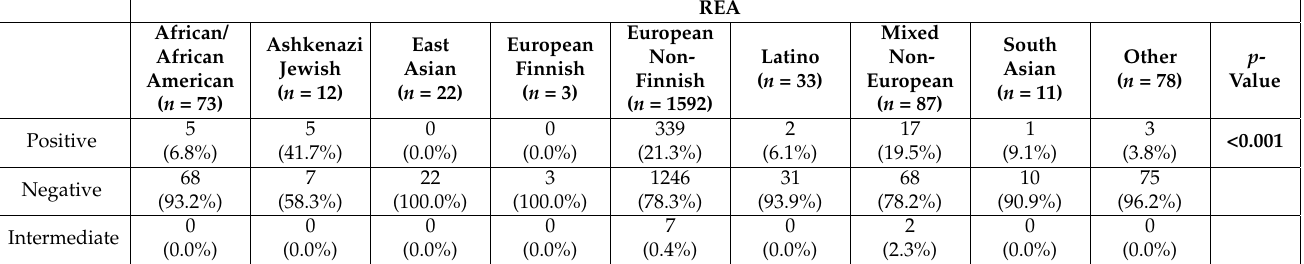
Table 2. Identification of the C9orf72 HRE across all